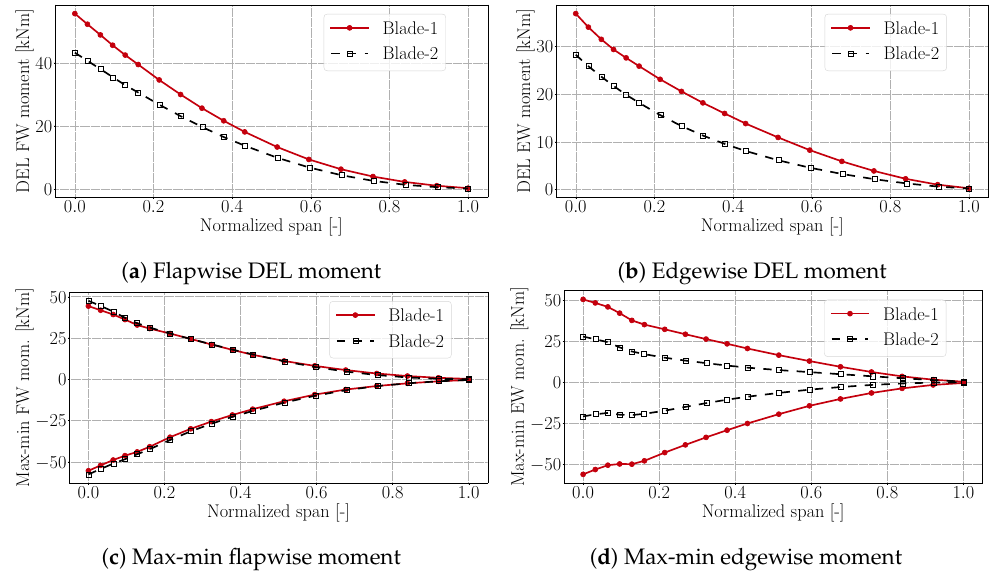
Figure 15. DEL and maximum—minimum moment loads in FW and EW directions along the normalized blade span. Damage equivalent loads are computed for DLC 1.2 load cases whereas maximum—minimum loads are from DLC 1.3 load cases.